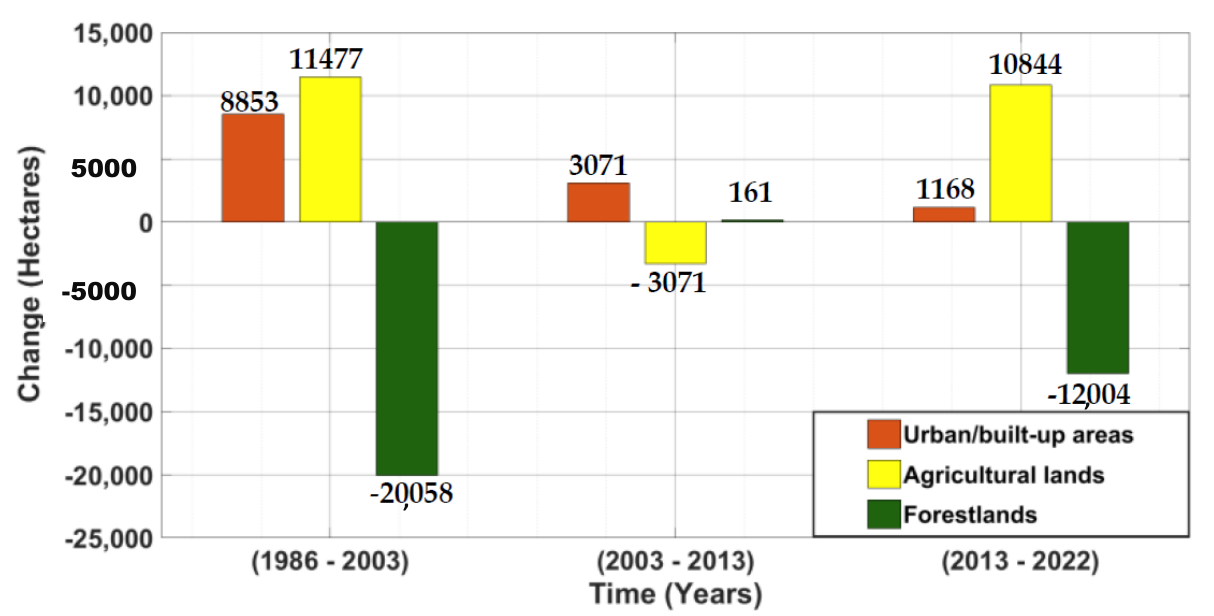
Figure 6. LULC change in hectares.